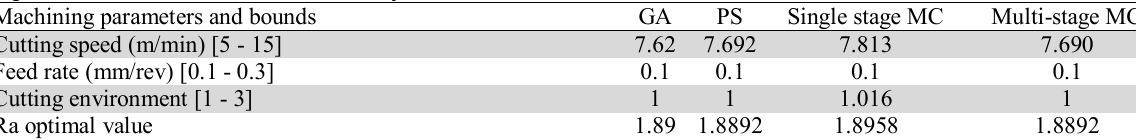
Optimization solutions of case study